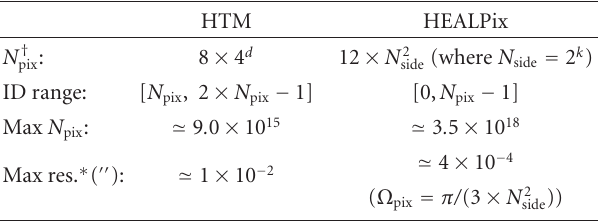
Table 1: Relevant parameters for the HTM and HEALPix sphere